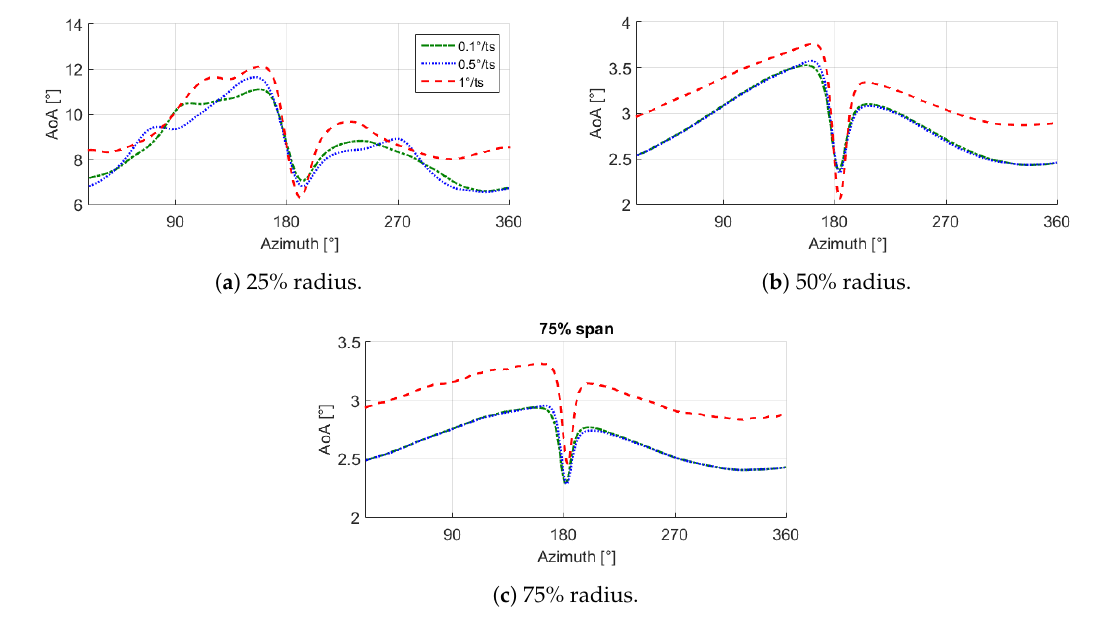
Figure 5. Angle of attack for one blade, at three different points along the blade span. The angle of attack was determined using Rahimi’s three point method